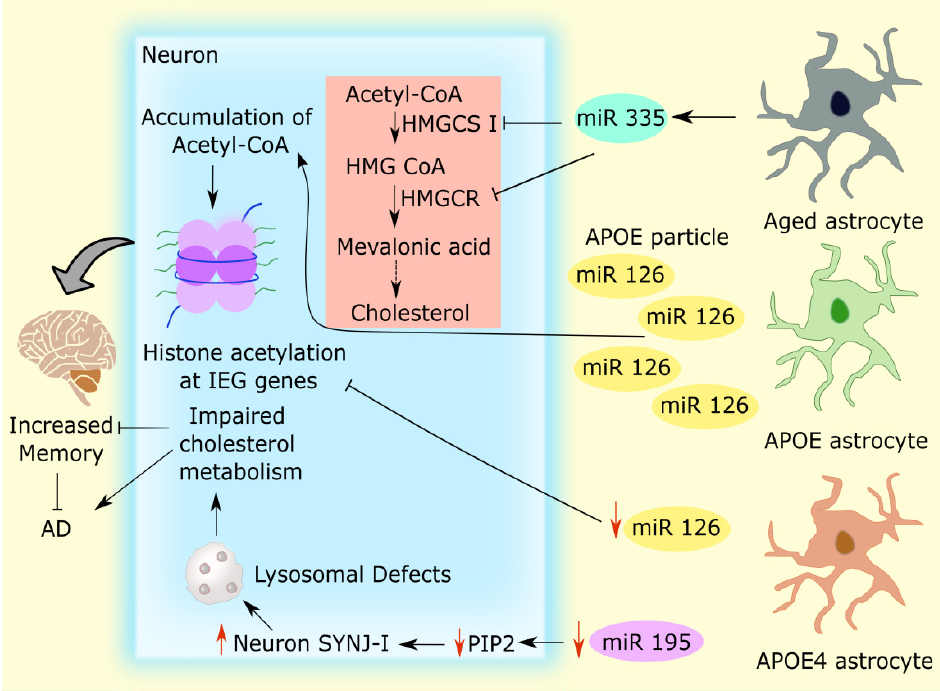
Figure 1. Astrocyte-neuron crosstalk through miRs and APOE-mediated cholesterol regulation. Astrocytes communicate with nearby neurons by delivering miRs. The APOE-induced astrocyte (GREEN) releases miRs, and miR-126 suppresses the genes involved in the generation of neuronal cholesterol, which in turn causes acetyl-CoA accumulation in neurons. As a result, increased H3K27ac enrichment and histone acetylation at several IEG genes (VIOLET) cause enhanced memory consolidation. However, APOE4-induced astrocytes (PALE RED) cause miR-126 trafficking from astrocytes to neurons to considerably decrease, which in turn reduces the histone acetylation at the promoters of IEGs. Ultimately, it leads to decreased memory consolidation. Aged astrocytes (PALE BLACK) display greater miR-335-3p levels in astrocytes. However, miR-335-3p hampers both HMGCS1 and HMGCR, which results in reduced cholesterol production leading to AD. Additionally, neuronal miR-195 is markedly reduced by astrocyte-induced APOE4, which caused PIP2 levels to drop and SYNJ1 levels to rise. Higher levels of SYNJ1 are associated with enlarged endosomes and lysosomal defects, which impair the metabolism of cholesterol in neurons and lead to AD. This picture shows how dysregulation of cholesterol production in astrocytes affects AD modulation in both protective and pathogenic aspects. miRs: microRNAs; AD: Alzheimer’s disease; ApoE4: